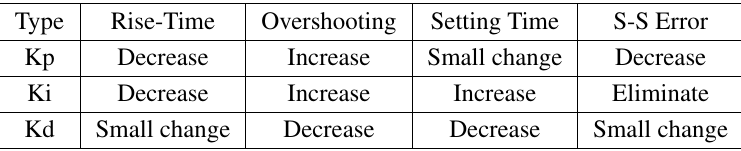
Table 3. Effects of increasing PID